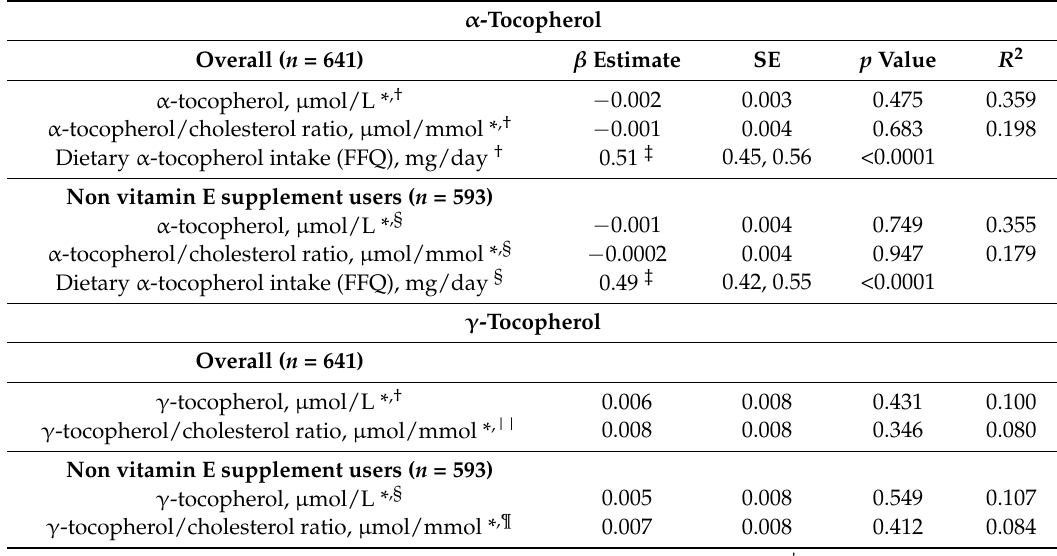
Table 5. Multivariable-adjusted linear regression models for the association between an a prioriderived, vitamin E rich dietary pattern with plasma α - and γ -tocopherol levels and dietary α -tocopherol